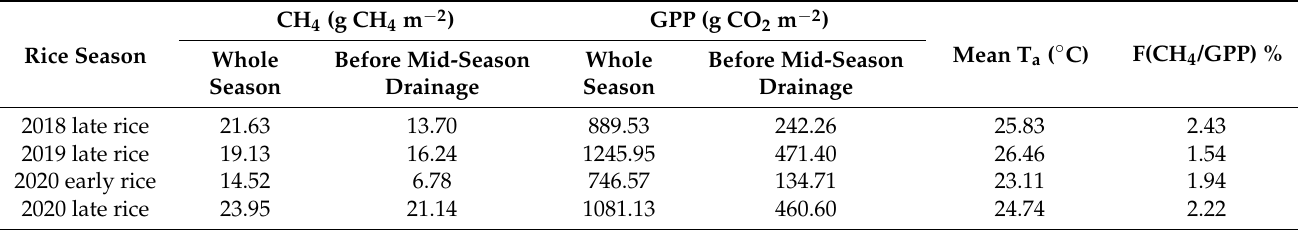
Figure 6. Time series of ( a ) SWC, ( b ) CH 4 fluxes, and ( c ) T s5 for 24–29th August, 2019. Table 3. CH 4 emissions, GPP during the whole season and before mid-season drainage, mean T a , and the ratio of CH 4 to GPP for the whole growing season in the four growing